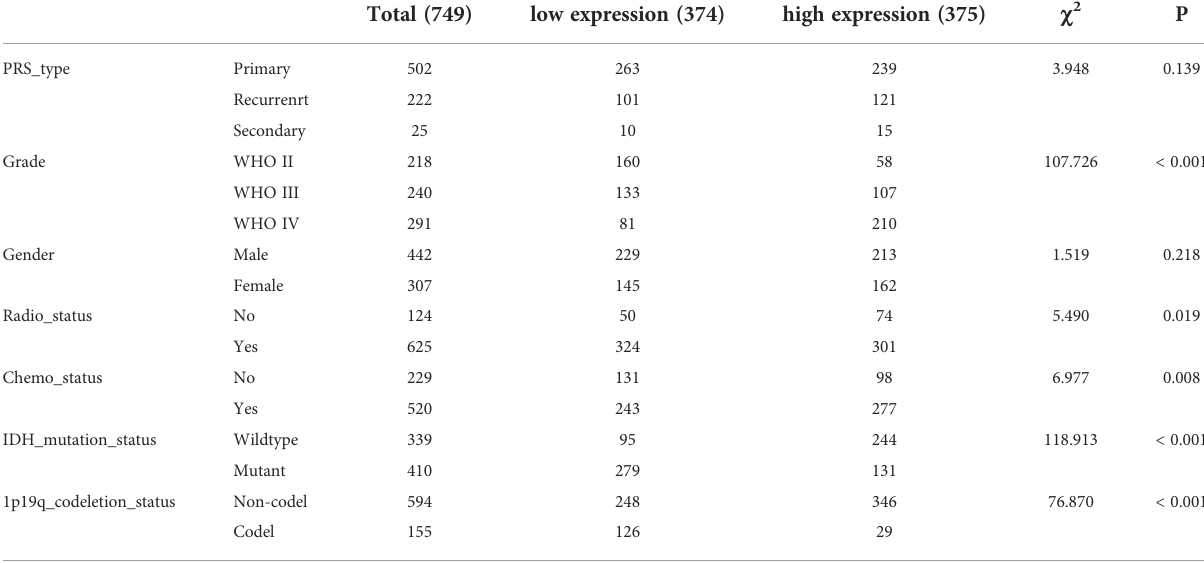
TABLE 1 Correlation between TP53I13 expression and different clinical factors based on